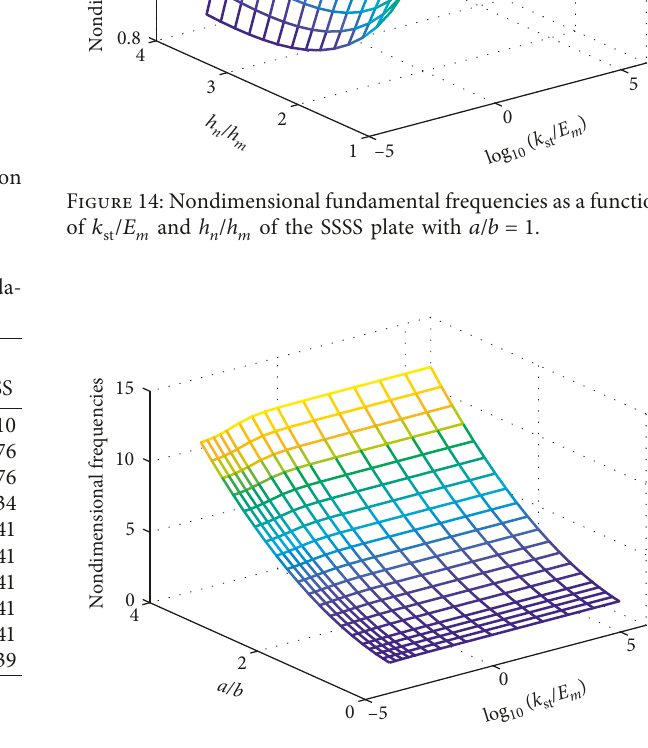
Figure 15: Nondimensional fundamental frequencies as a function of k / E m and a / b of the SSSS plate with h n / h m � 1. st